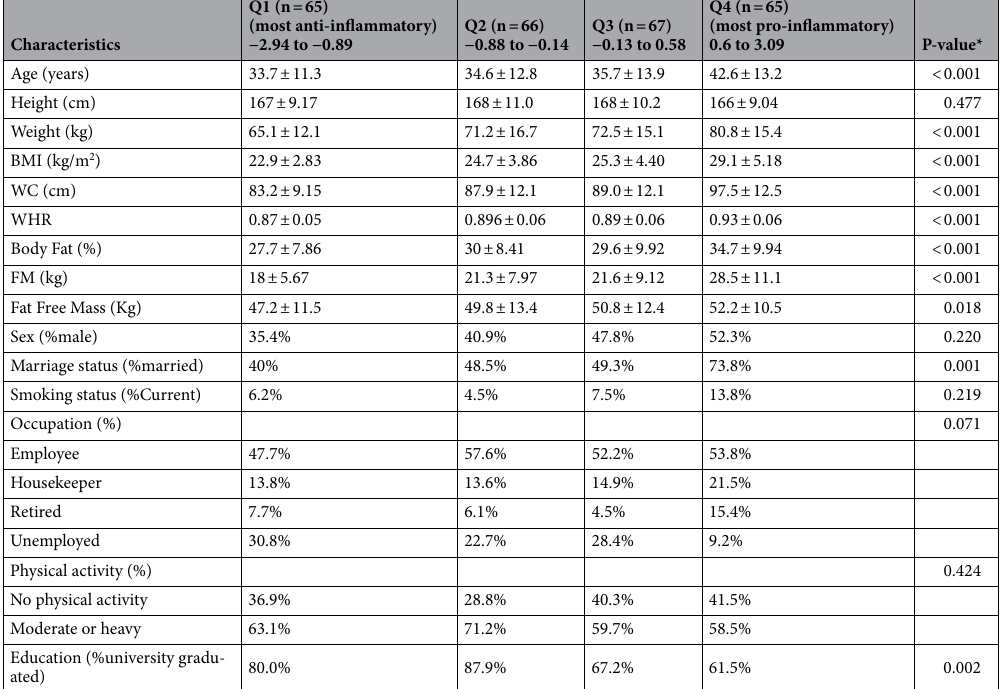
Table 1. Characteristics of participants according to quartile of the dietary and lifestyle inflammation score. BMI, body mass index; Q, quartile; WC, Waist Circumference; FFM, fat-free mass; FM, fat mass; WHR, waist-to-hip ratio. The values are presented as mean ± SD for continuous variables and percent for categorical variables. *ANOVA test was used for quantitative data and chi-square test for qualitative data. P < 0.05 is